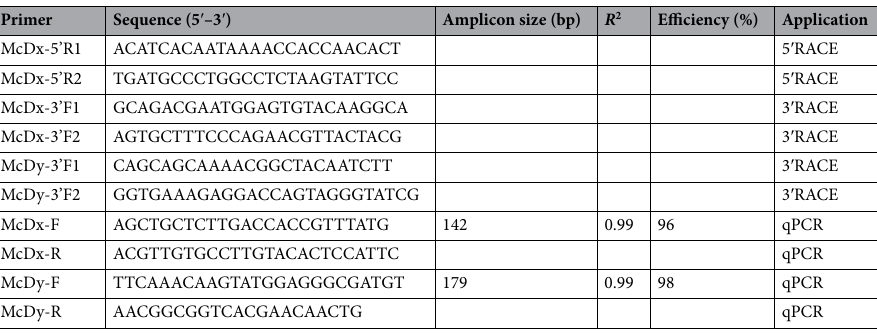
Table 1. List of the primers used in RACE PCR and real-time quantitative PCR (qPCR) in this